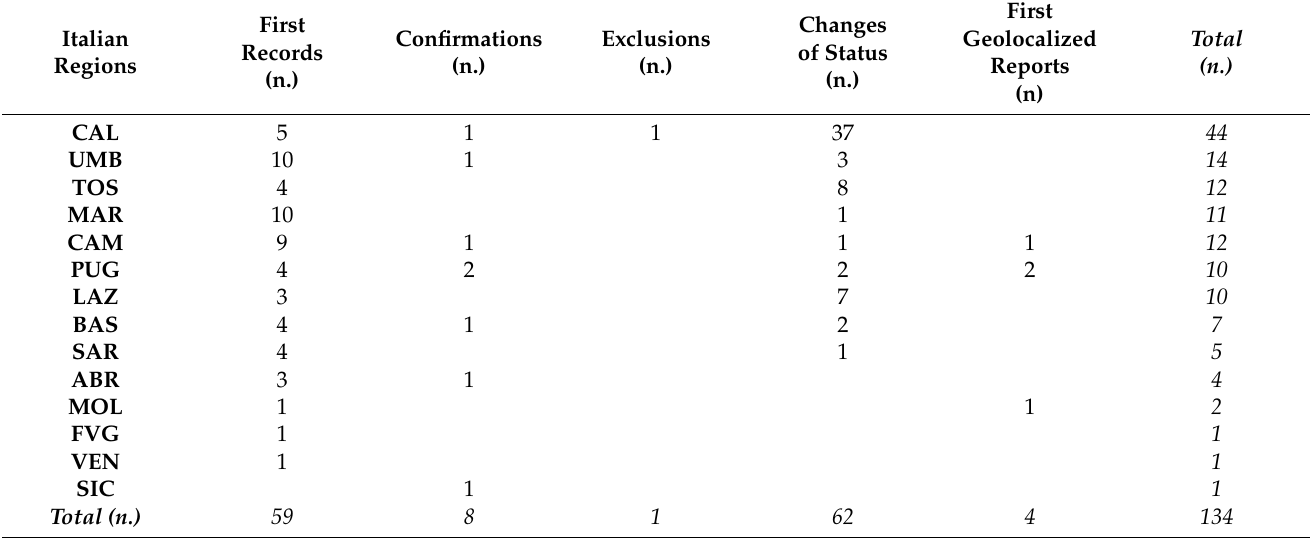
Table 1. New floristic records for the Italian regions according to our field, herbarium and literature researches (CAL: Calabria; UMB: Umbria; TOS: Toscana; MAR: Marche; CAM: Campania; PUG: Puglia; LAZ: Lazio; BAS: Basilicata;